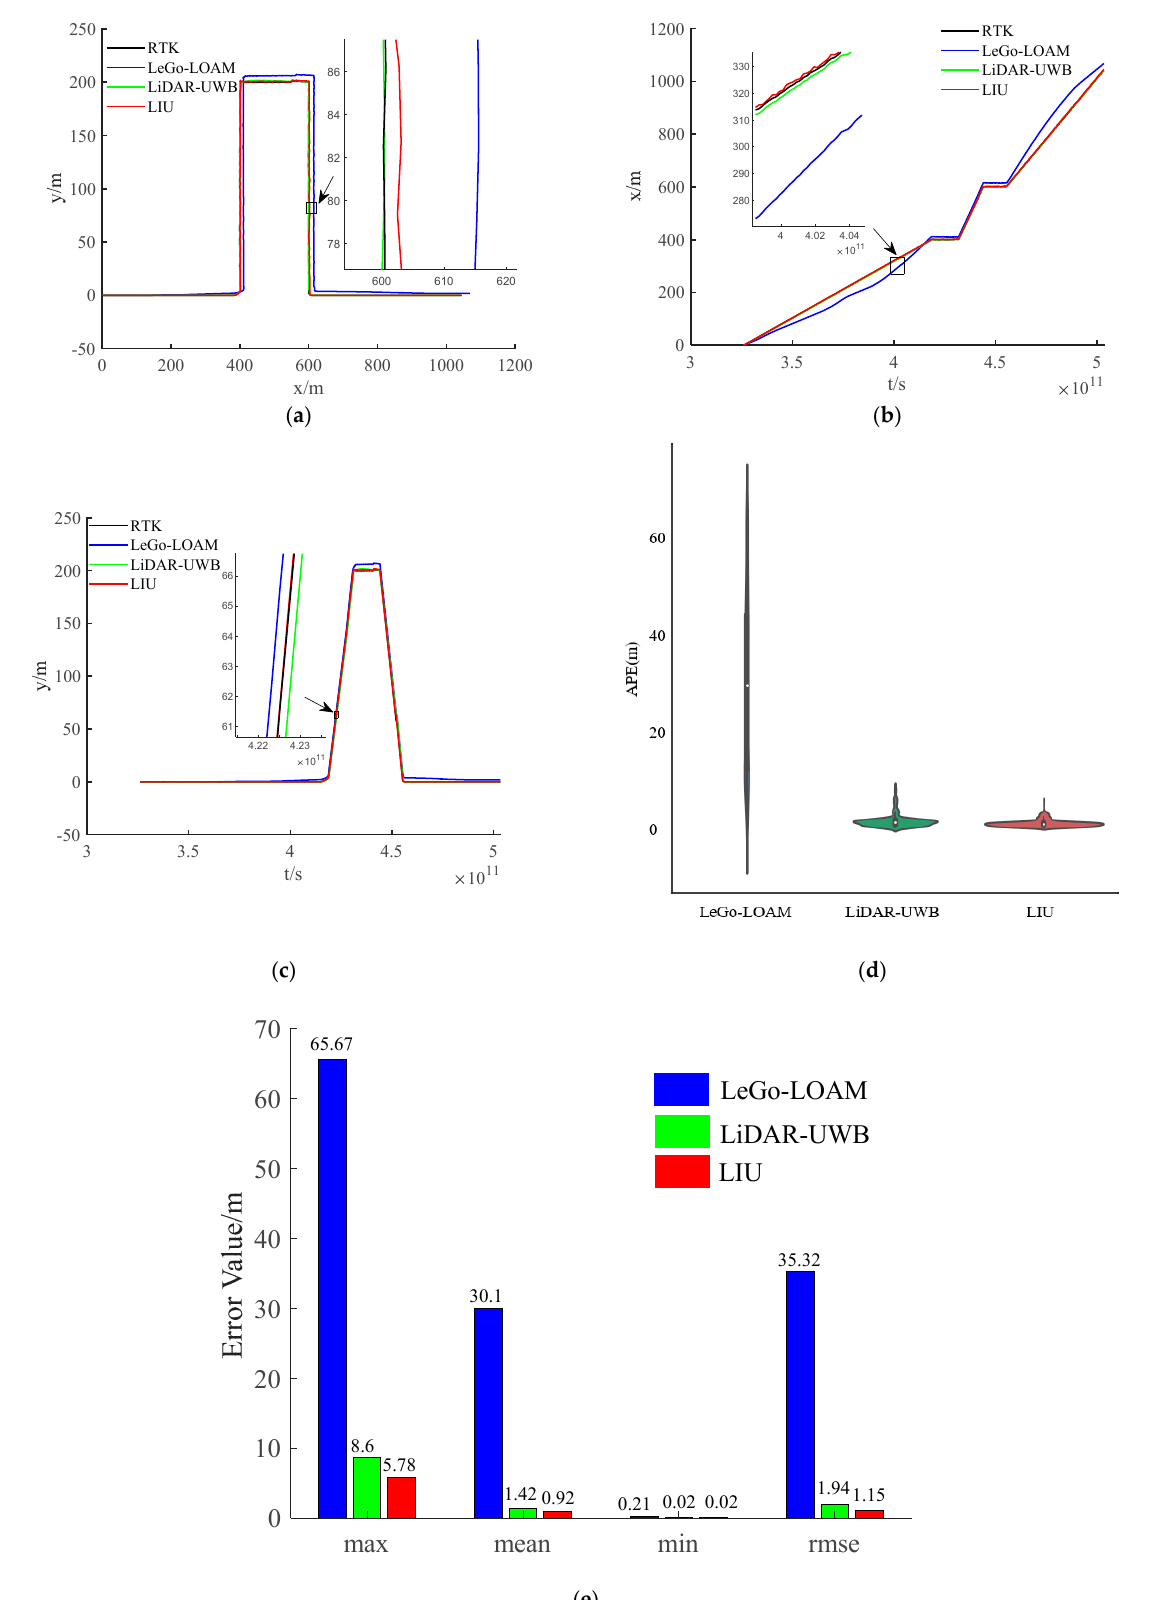
Figure 5. Experiment in a roadway with a length of about 85 m. ( a ) Trajectory curve; ( b ) position error along x-axis; ( c ) position error along y-axis; ( d ) APE violin histogram; ( e ) error value comparison .